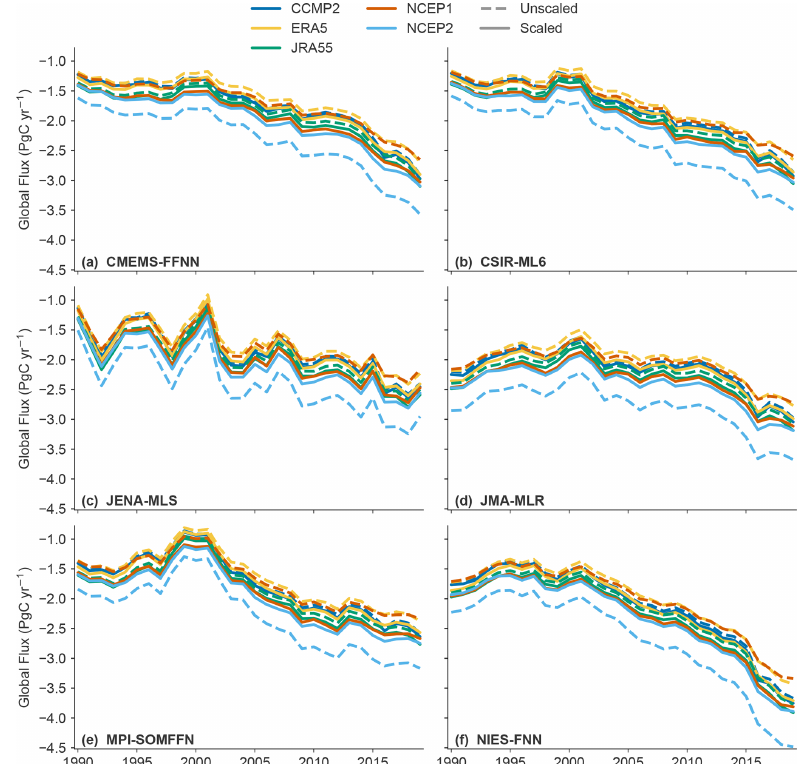
Figure A4. Air–sea CO 2 flux time series (PgCyr − 1 ) calculated using five wind speed products (CCMPv2, ERA5, JRA55, NCEP1, NCEP2), scaled (solid) and unscaled